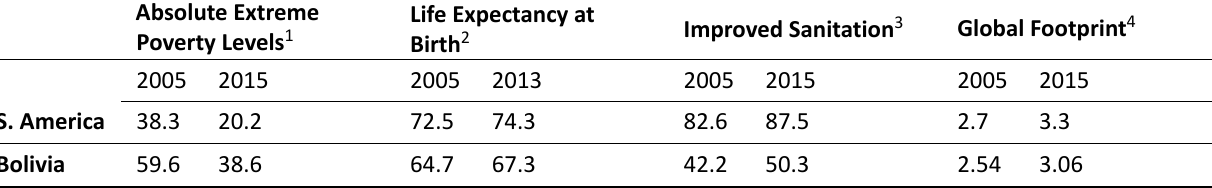
Table 1. Regional comparisons with South American countries (2005–latest data) on 4